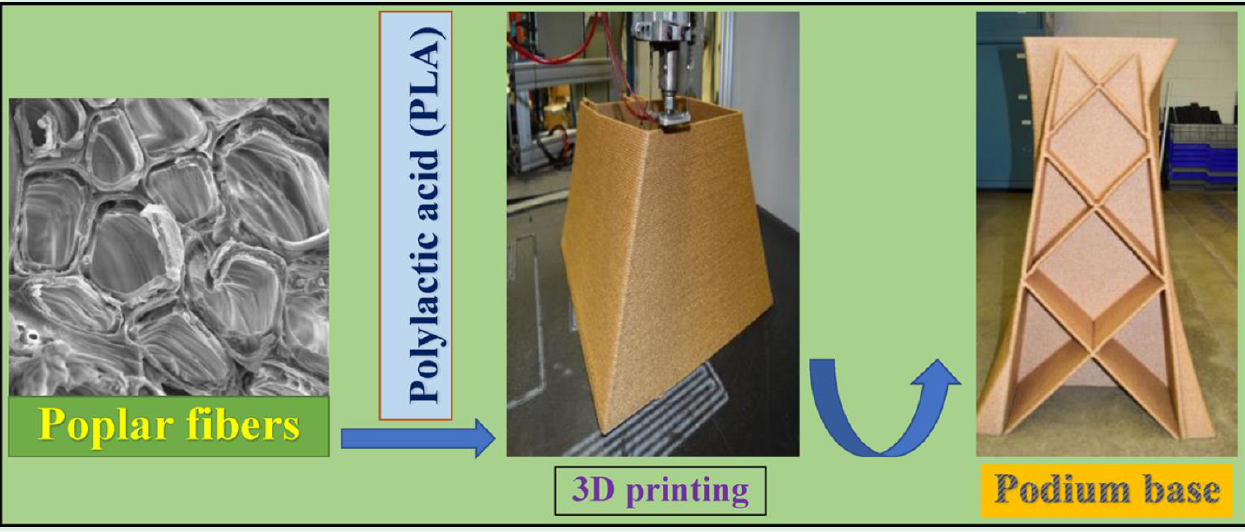
Figure 8. Large scale printing process with poplar/PLA composites. Adapted from Zhao X, Tekinalp H, Meng X, Ker D, Benson B, Pu Y, et al. [162]. ACS Appl Bio Mater 2019. Copyright (2019) American Chemical Society.